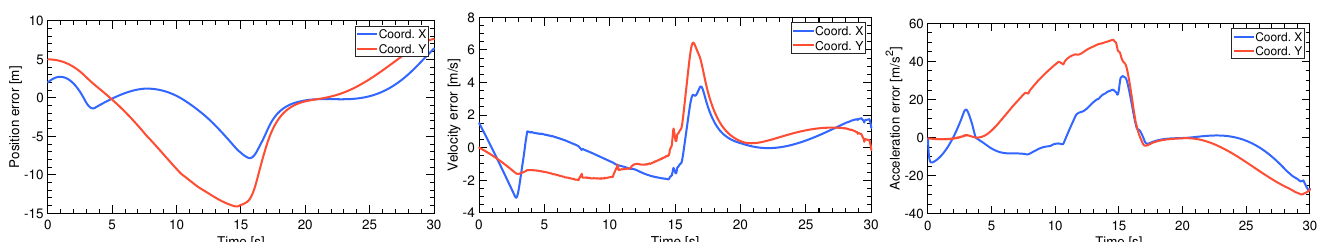
Figure 26. Trajectory following test (circular path) in case of incorrect tractive force estimation: position error ( left ), velocity error ( middle ), and acceleration error ( right ).